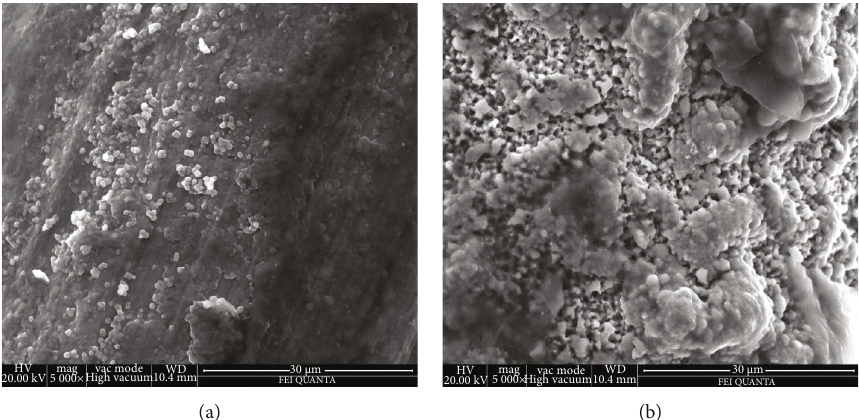
Figure 9: Surface morphology of heater surface: (a) 0.3% volume concentration Al